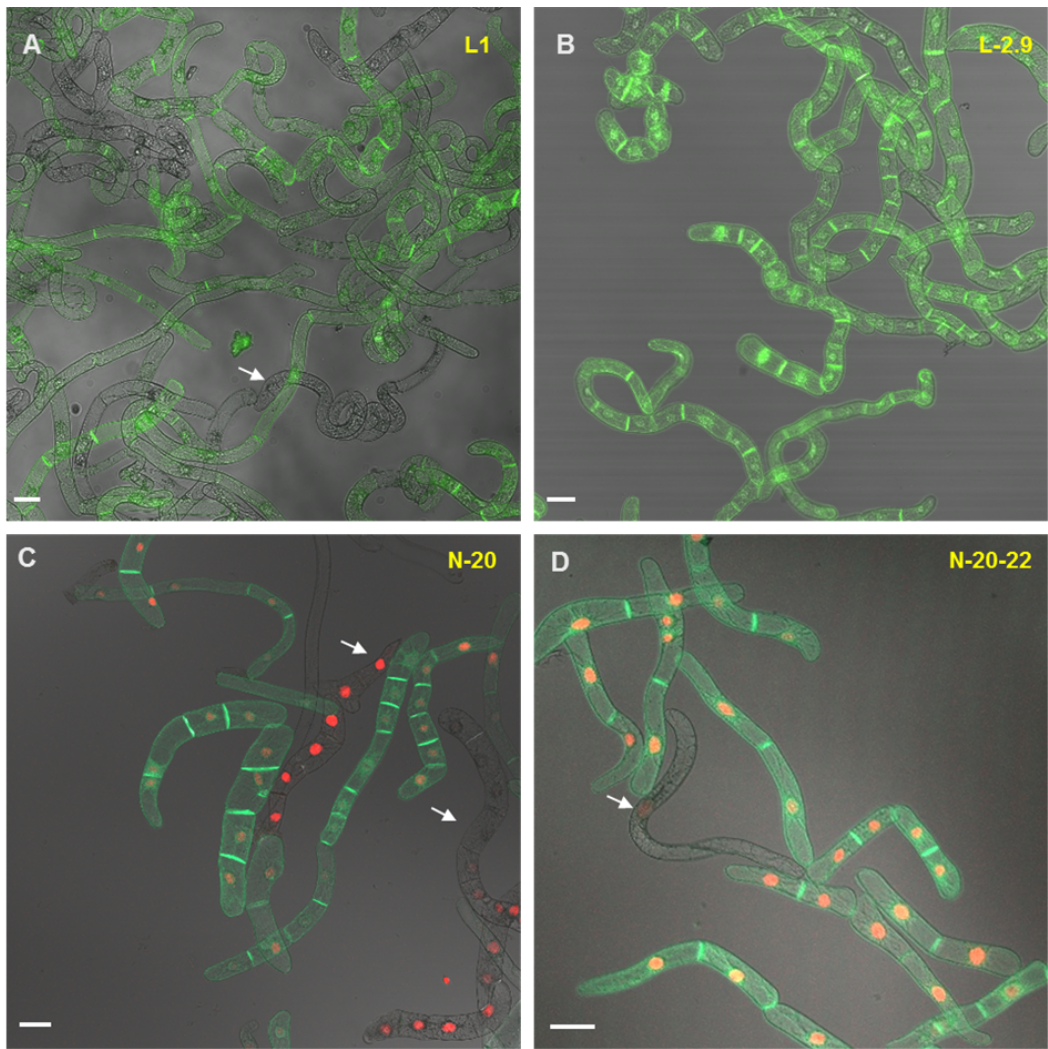
Figure 17. GFP and RFP fluorescence in primary and secondary suspensions. A - and C - �eterogeneity of GFP and RFP fluorescence in a suspension of transgenic BY-2 cells derived from primary calli. Arrows indicate cells with missing fluorescence or significant variations in fluorescence intensities (red and green fluorescence). B - and D - Cell suspensions derived from re-selected calli (secondary calli). The fluorescence is strong and homogenous in both channels. Nevertheless some cells (less than 5%) show heterogeneity in fluorescence. Possible reasons are discussed in the main text. White bars indicate 20